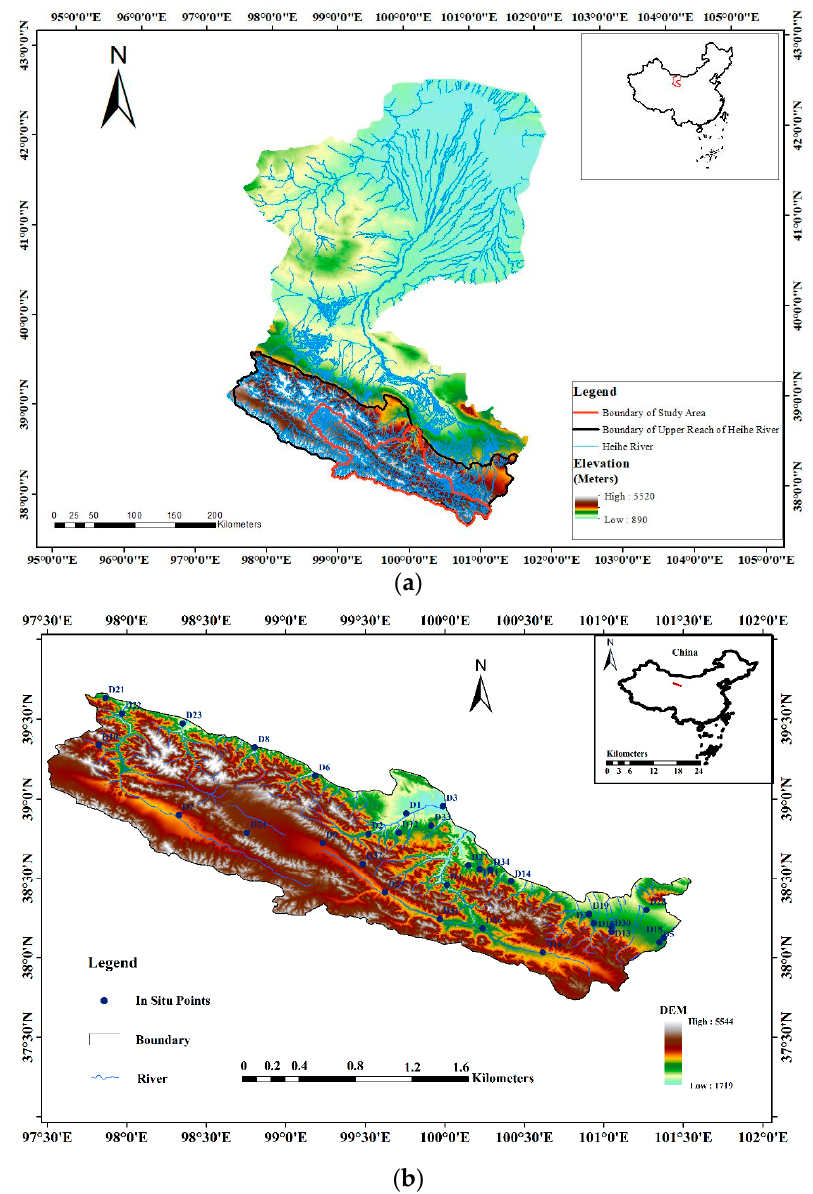
Figure 1. The Study area ( a ) The Heihe River Watershed in Northwest China; ( b ) The upper reach of the Hehe River Watershed.